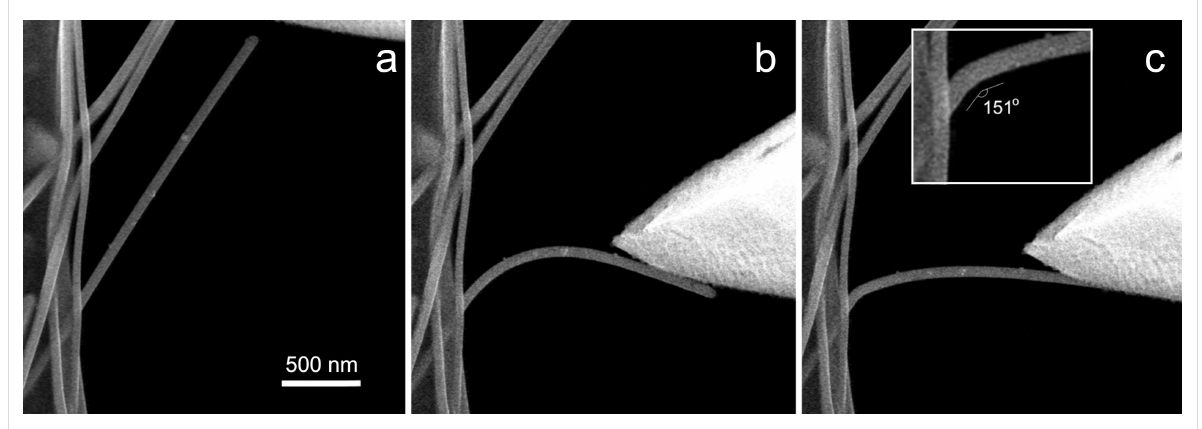
Figure 4: Ag NW bending experiment observed inside a SEM. (a) Straight NW before bending, (b) NW bent close to the critical bending angle, (c) abrupt elastic-to-plastic transition occurred.